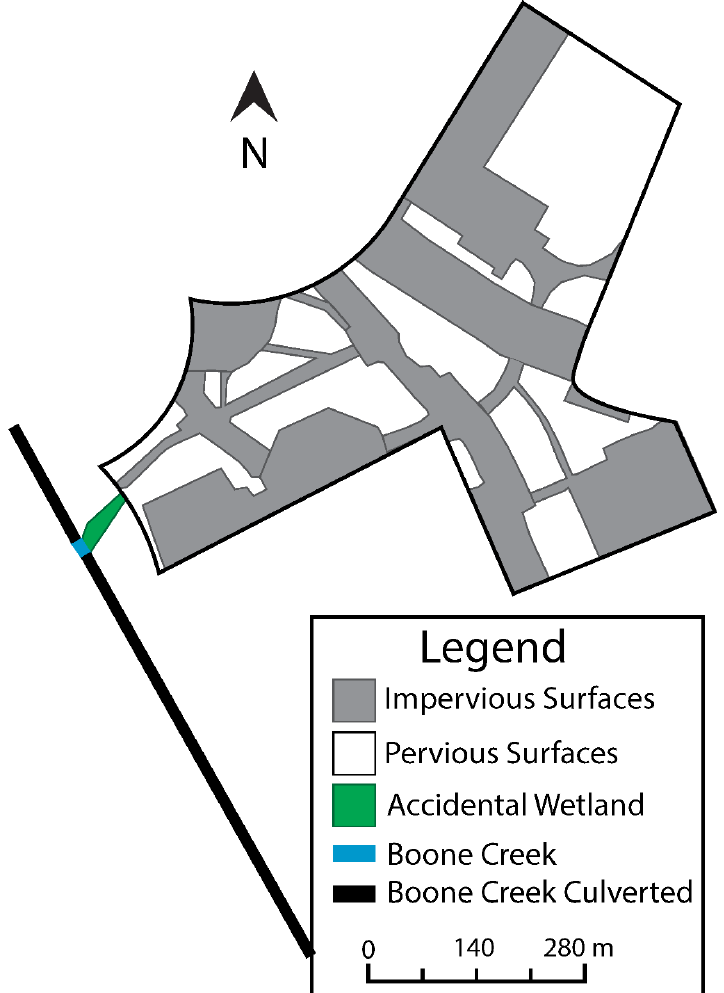
Figure 3. Total area of the drainage basin for the Accidental Wetland (AW) site. Gray areas indicate impervious surfaces such as sidewalks, roads, and rooftops and the white areas represent green spaces.